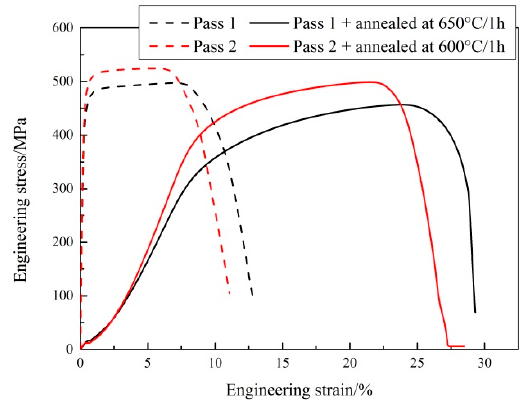
Figure 9. Engineering stress-strain curves of CGP nickel sheets before and after post-deformation annealing. Metals 2019 , 9 , 1047 10 of 12